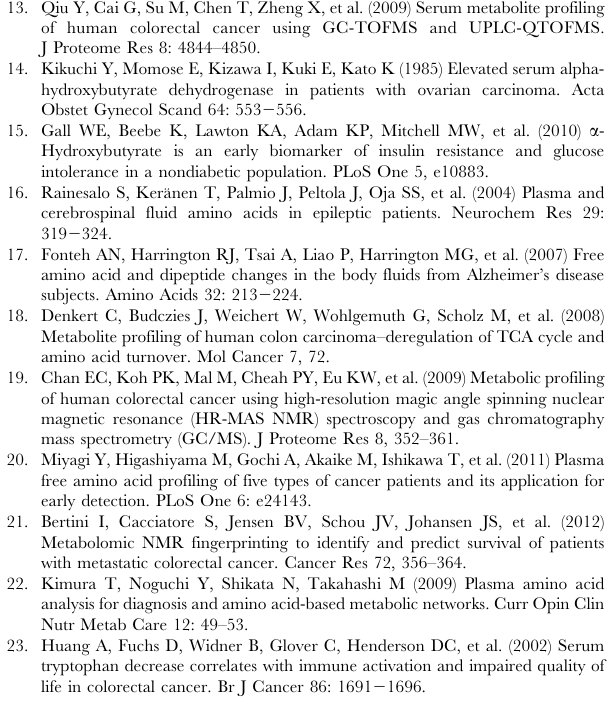
Table S3 The RSD%, inter-day variance, and intra-day variance values of serum metabolites. Table S4 Comparison of serum metabolite levels between the colorectal cancer patients and healthy volunteers in the training set. Table S5 Comparison of serum metabolite levels between the colorectal cancer patients and healthy volunteers in the data set mixing the training set